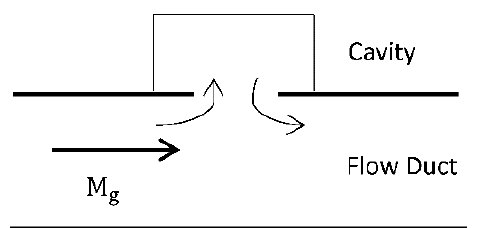
Figure 1. Illustration of a grazing flow-induced neck flow in a single perforation.